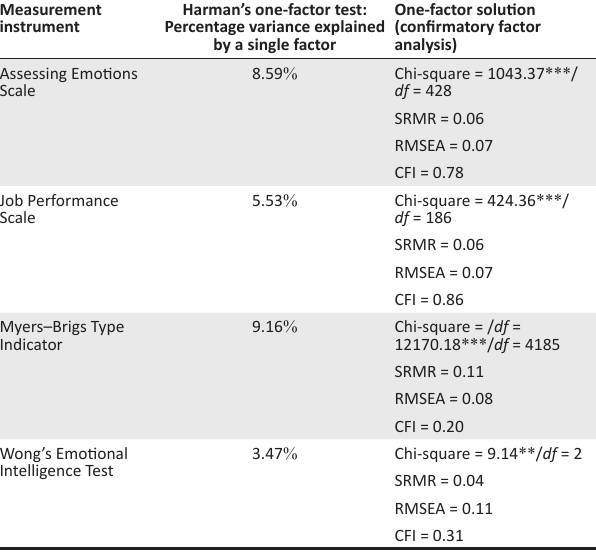
TABLE 1: Testing for common method